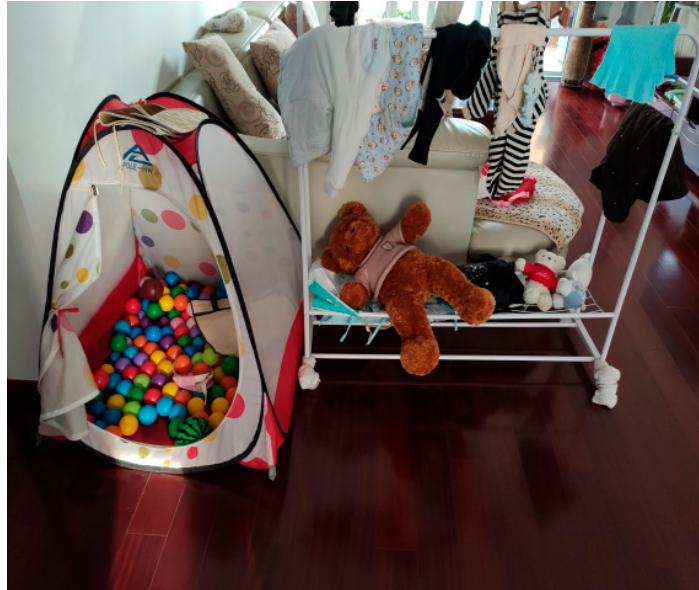
Figure 2. Combustibles in the living room.